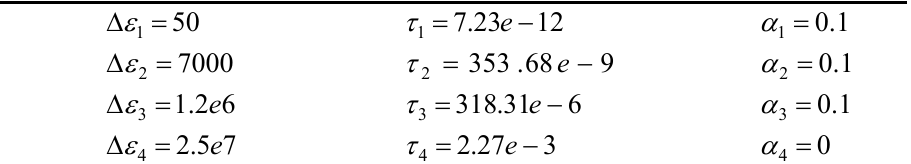
Table 1. 4 term Cole-Cole model parameters for